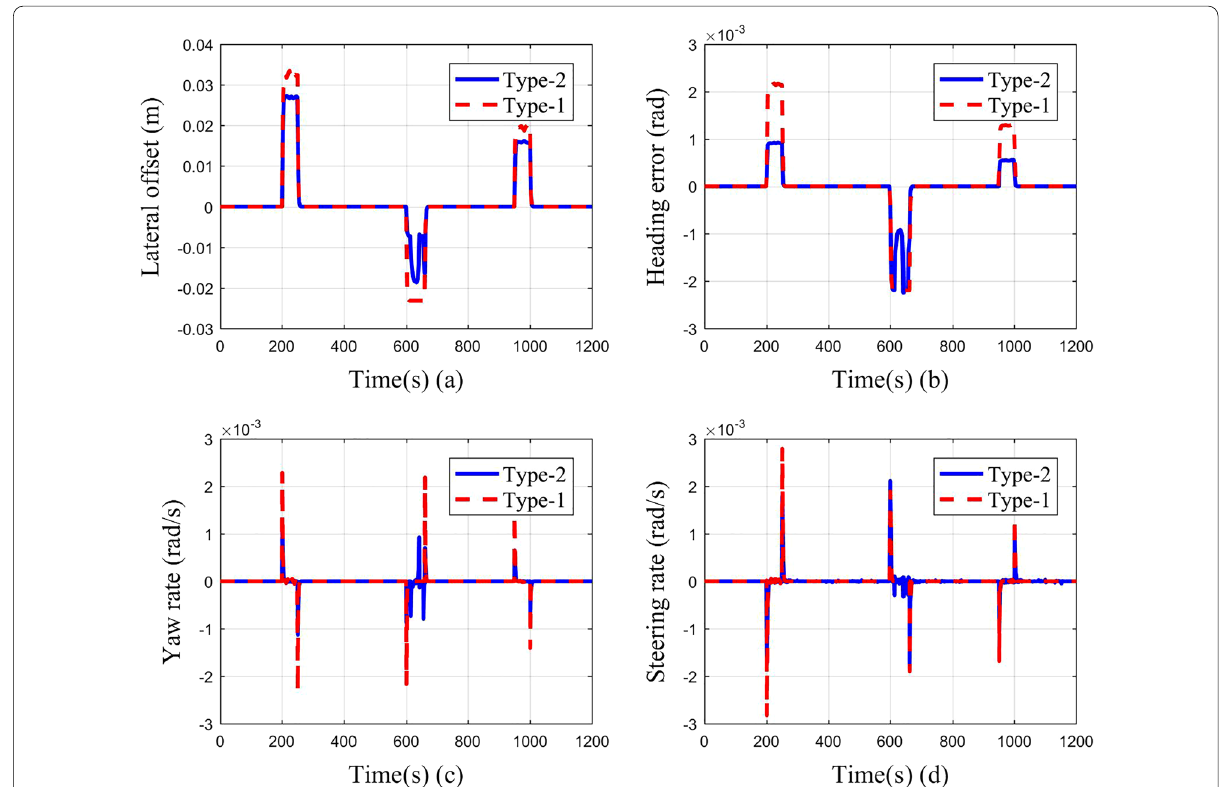
Figure 10 Response of vehicle states in accordance with measured vehicle speed